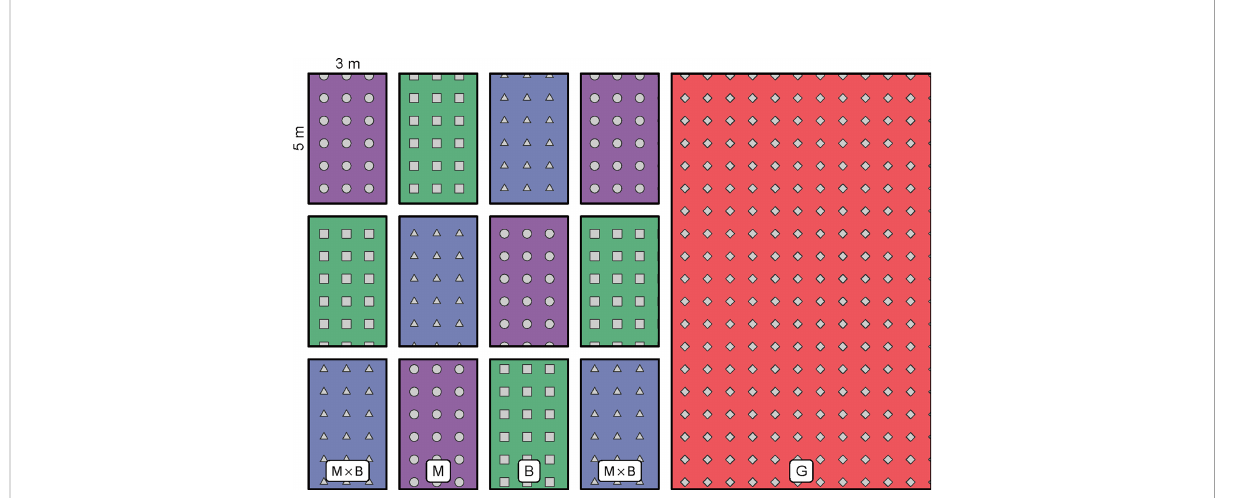
FIGURE 3 Plot arrangements for alfalfa monoculture (M), smooth bromegrass monoculture (B) and M×B mixture in the fi eld experiment. A large plot of fence-enclosed natural grassland (G) is located next to the grass plantation